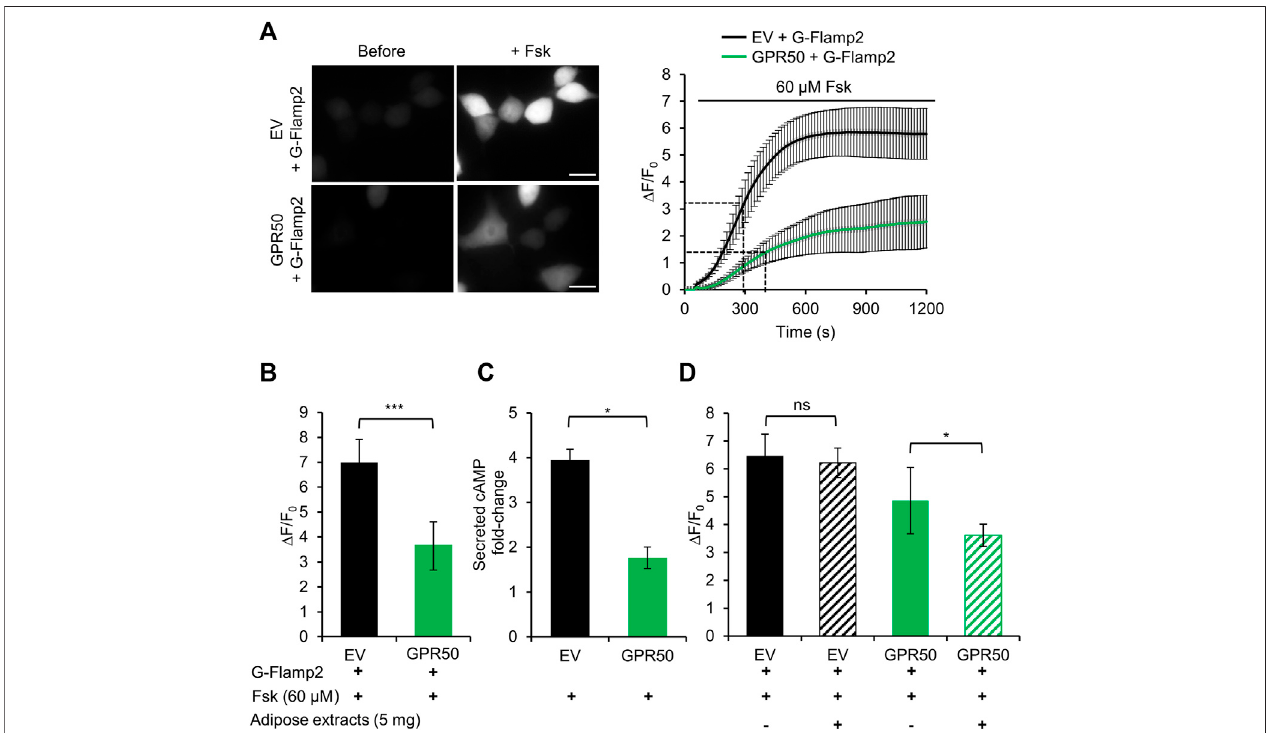
FIGURE 4 | Adipose tissue extract activates the orphan GPCR GPR50 in HEK293T cells. (A) Representative fl uorescence images (left) and traces of Δ F/F 0 in response to 60 μ M Fsk of G-Flamp2 in HEK239T cells stably expressing Empty Vector (EV) or GPR50 receptor (GPR50) (right). n = 14 and 10 cells for EV and GPR50, respectively. (B) Peak Δ F/F 0 inresponse to60 μ MFskinHEK293T cellsstablyexpressing EVorGPR50. (C) Quanti fi cationofintracellular cAMPlevels inEVand GPR50 cells after 20 min in stimulation of 60 μ M n = 3 cultures for both. (D) Peak Δ F/F 0 in response to 5 mg/ml adipose extracts pretreatment for 5 min with 60 μ M Fsk in HEK293TcellsstablyexpressingEVorGPR50.Scalebars:50 μ m.Dataarepresentedasthemean±standarddeviation(SD).* p < 0.05,*** p < 0.001asmeasured bya Two-tailed Student ’ s t